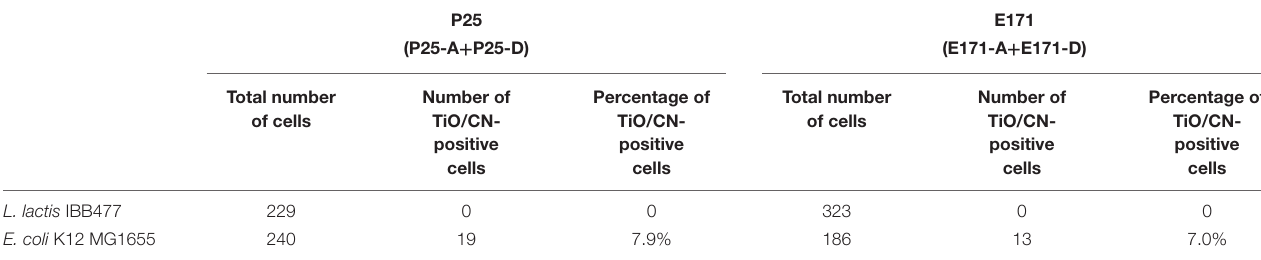
TABLE 3 | Titanium dioxide internalization within L. lactis and E. coli cells as determined with high-resolution nano-secondary ion mass spectrometry (Nano-SIMS) chemical imaging.